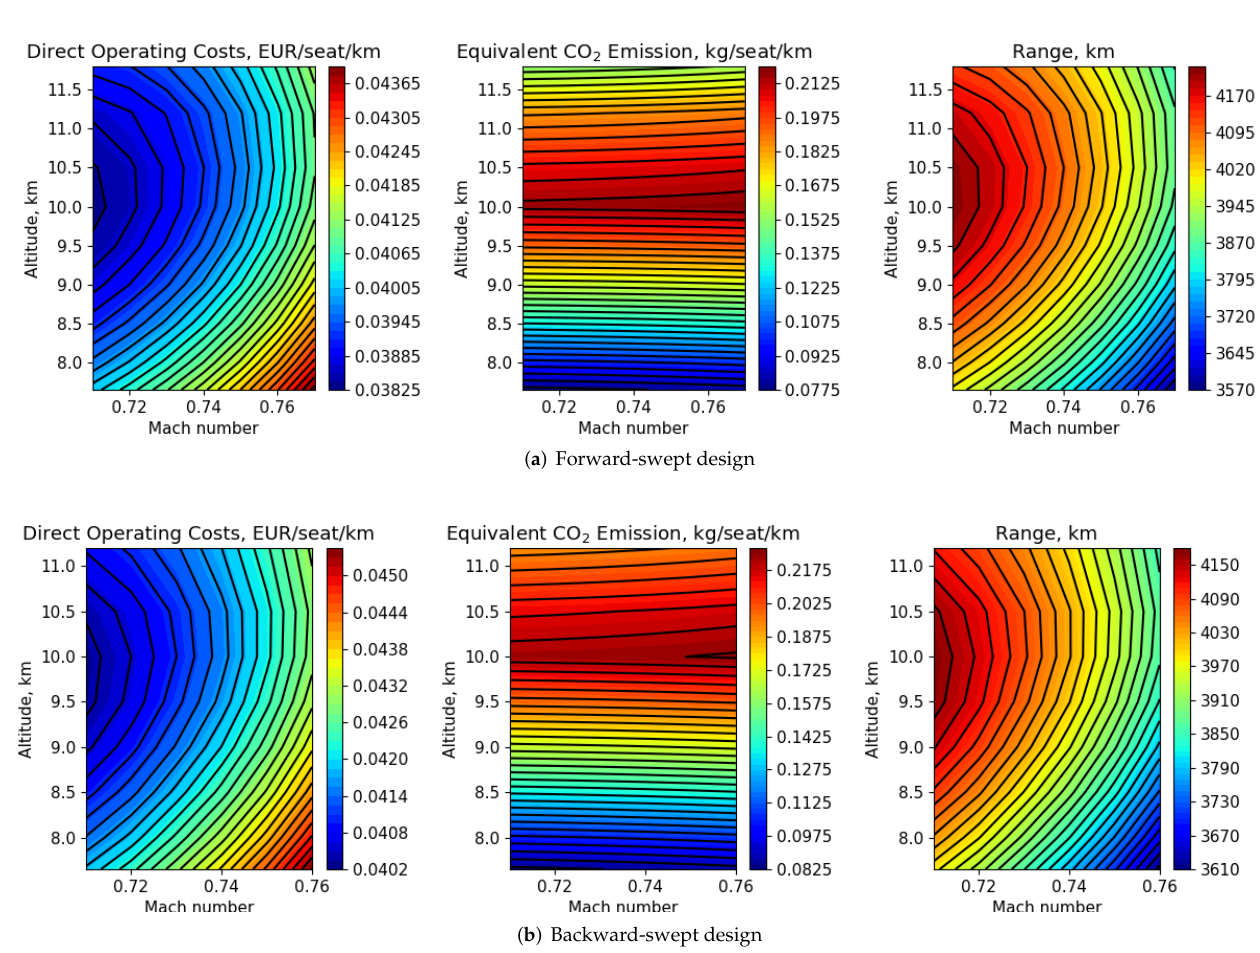
Figure 16. Aircraft performance for optimized mid-range aircraft.